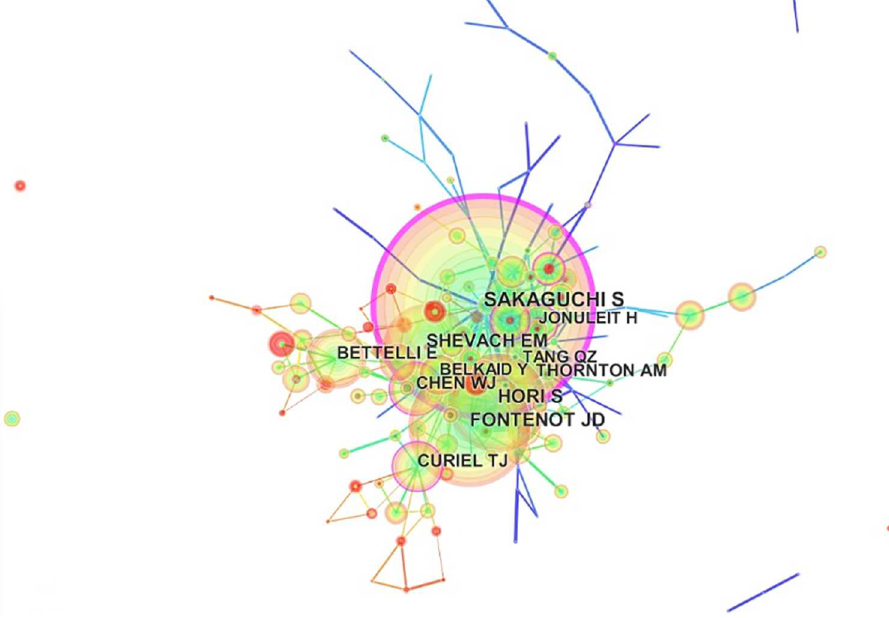
Fig 5. Co-citation map of authorswho publishedarticlesrelatedto regulatory T cell (Treg) research from 2000 to